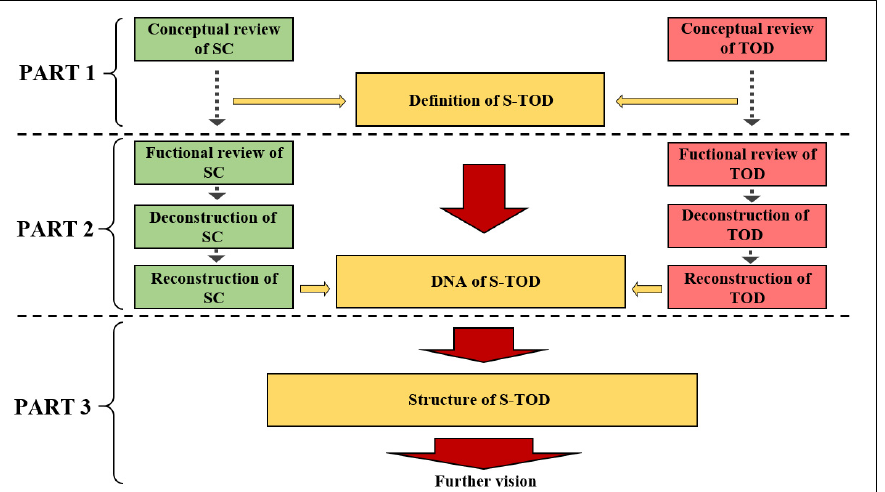
Figure 2. The three main parts of the